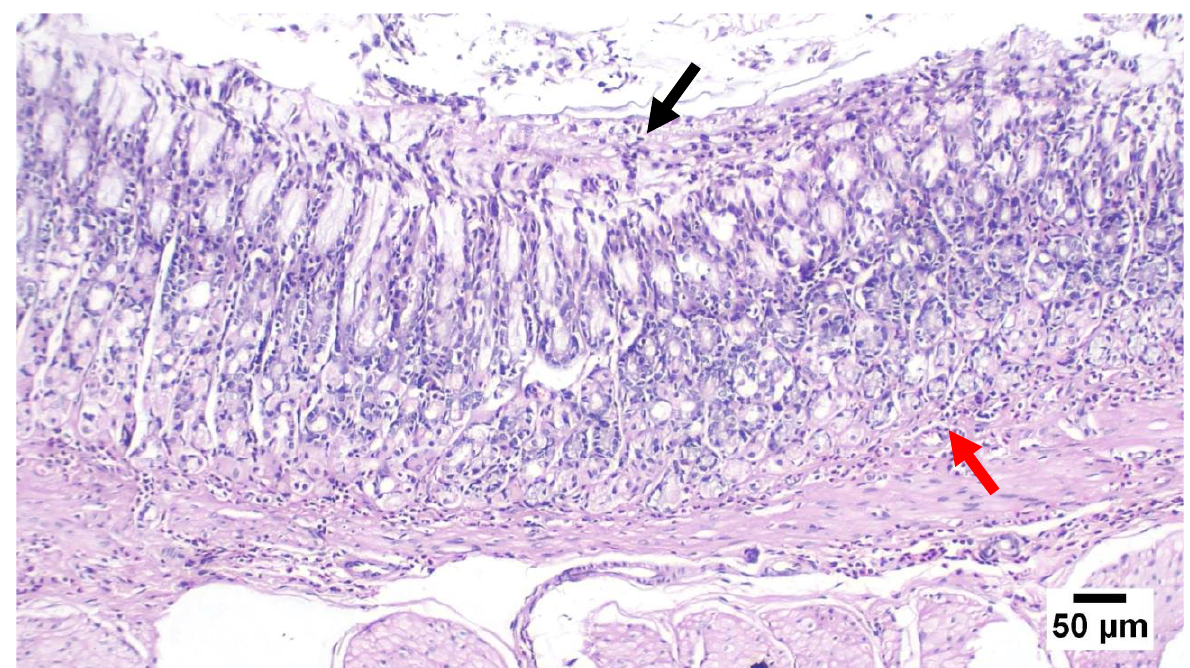
Figure 15. Photomicrograph of stomach, G1-D3-Asp , showing surface epithelial loss with exaggerated mucous secretion (black arrow) and mononuclear inflammatory cells infiltration (red arrow) (H&E).